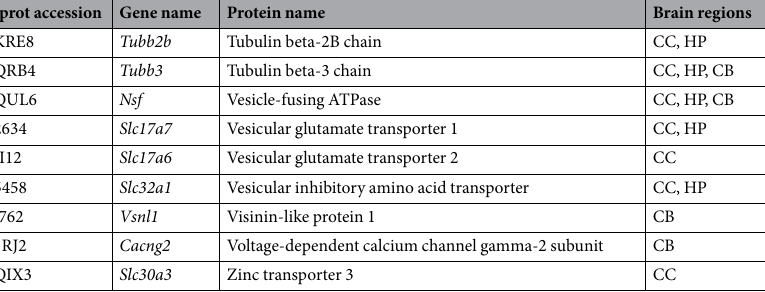
Table 1. Novel candidate BRI2 interacting proteins highly enriched or specific for the brain tissue. Uniprot accession numbers, gene and protein names, are listed, as well as the rat brain tissues where the proteins were found. CC, cerebral cortex; HP, hippocampus; CB, cerebellum.